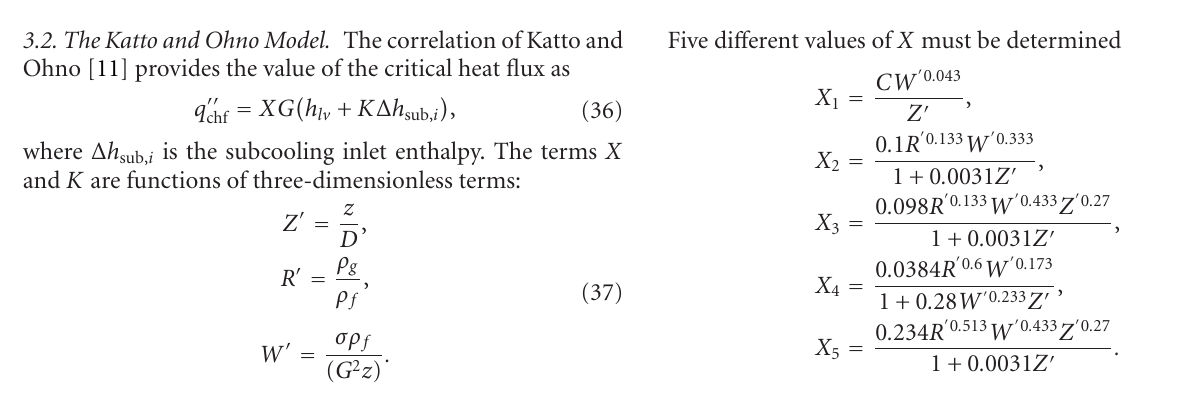
Figure 7: Computed versus experimental critical heat fluxes (Series